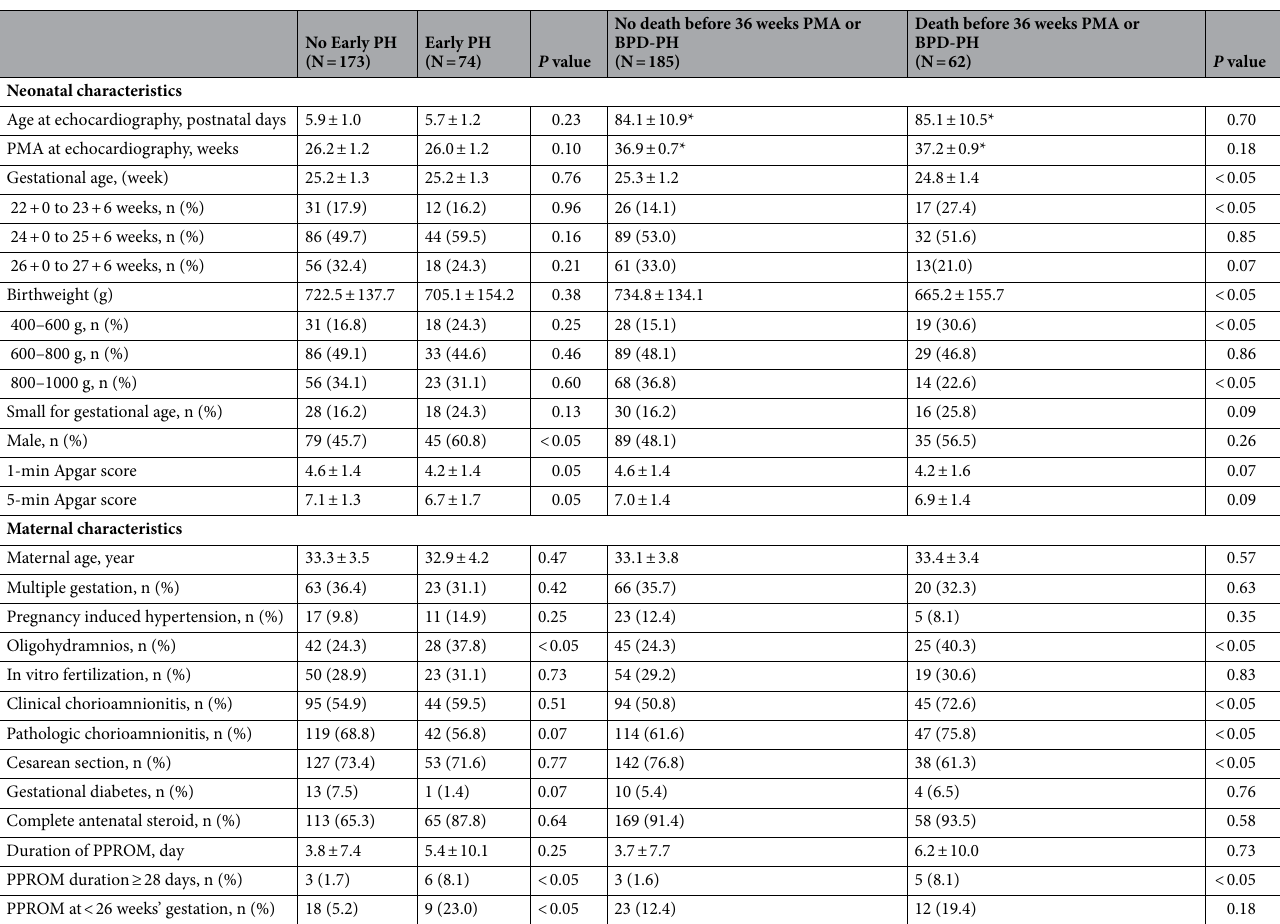
Table 1. Perinatal demographic characteristics. *Echocardiographies were done only in m/s BPD patients at 36–38 weeks PMA; PH pulmonary hypertension, m/s BPD moderate to severe bronchopulmonary